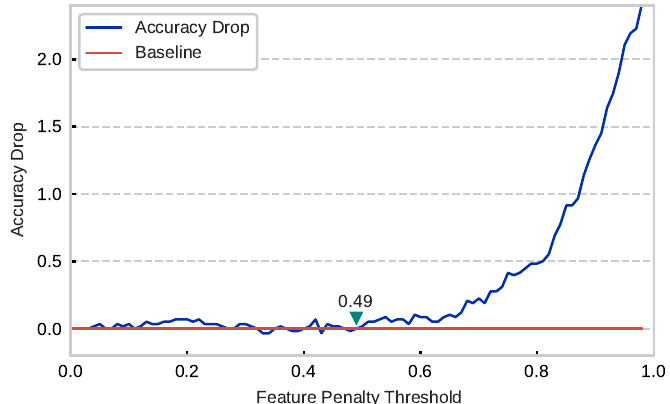
Figure 1. The increase in accuracy drop with increasing feature penalty threshold. Specifically, the optimal thresholds are different for each layer. Thus, the feature penalty was applied one layer at at a time and the optimal threshold was explored separately.